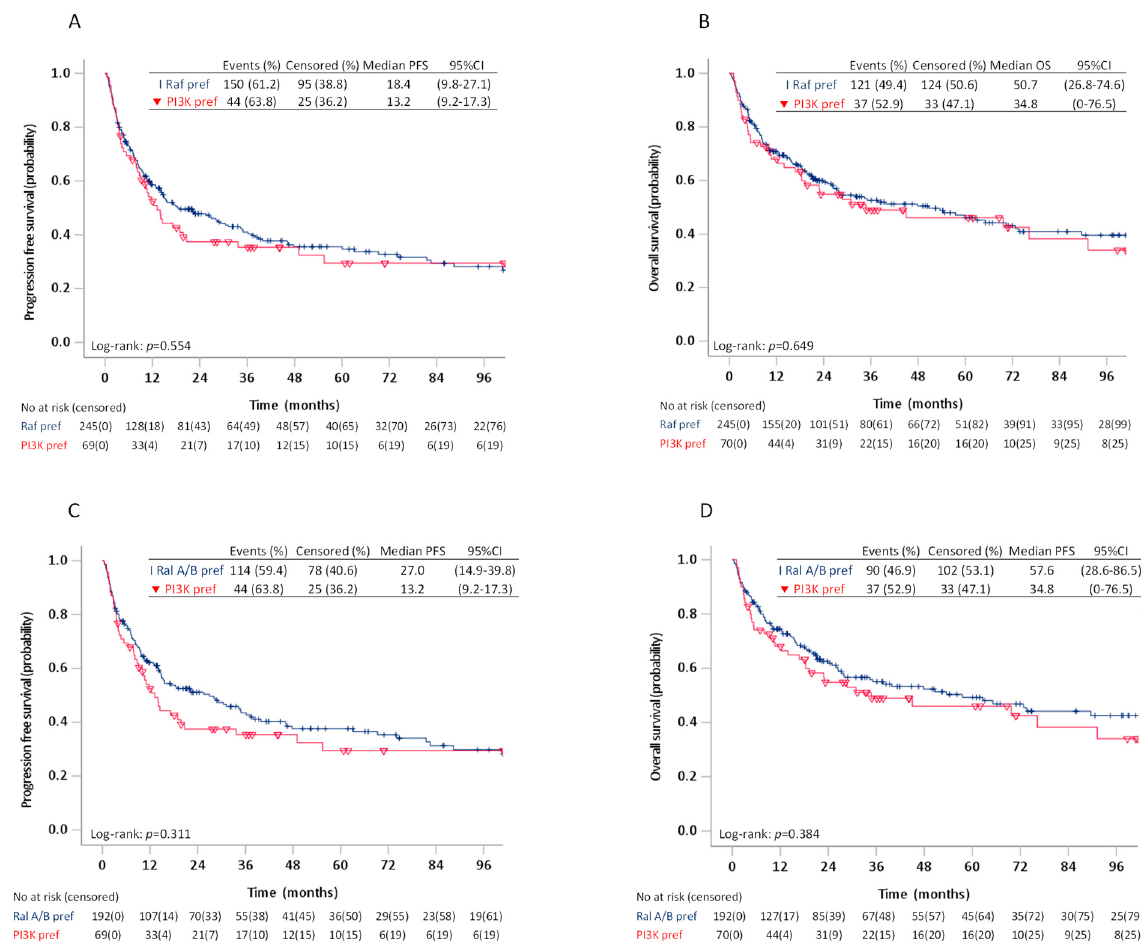
Figure 5. Progression free survival and overall survival in patients stage I–IV with KRAS mutants favouring the Raf pathway (G12C, G12A, G13D, Q61L/H) versus patients with KRAS G12D favouring PI3K/Akt ( A , B ) and patients with KRAS G12C favouring the RalA/B pathway versus patients with KRAS G12D favouring PI3K/Akt ( C , D ).